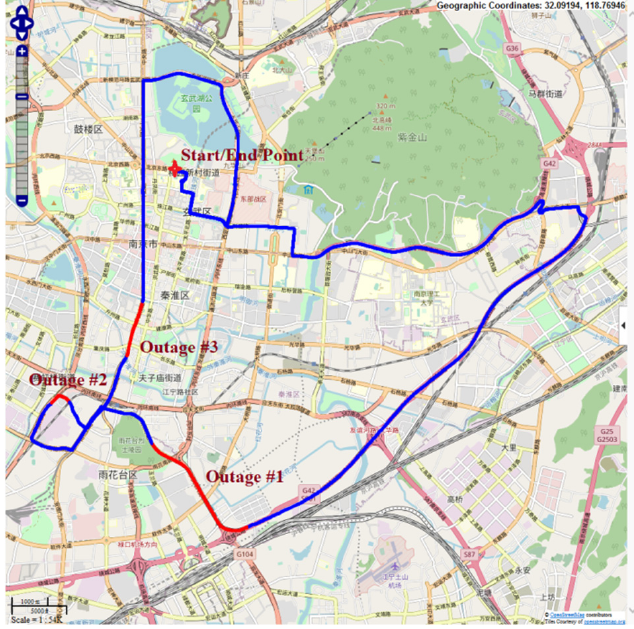
Figure 5. The vehicle’s experimental trajectory.